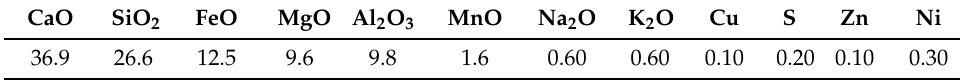
Table 1. The composition of the starting slag, in wt. %.